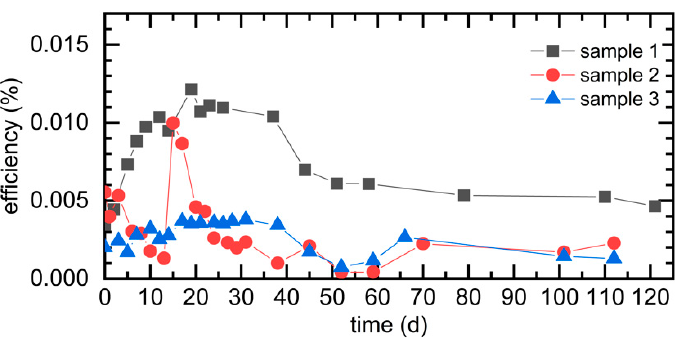
Figure 2. Efficiencies of PAN blended with PEO (samples 1 and 2) and PAN (sample 3) GPEs for 120 days.